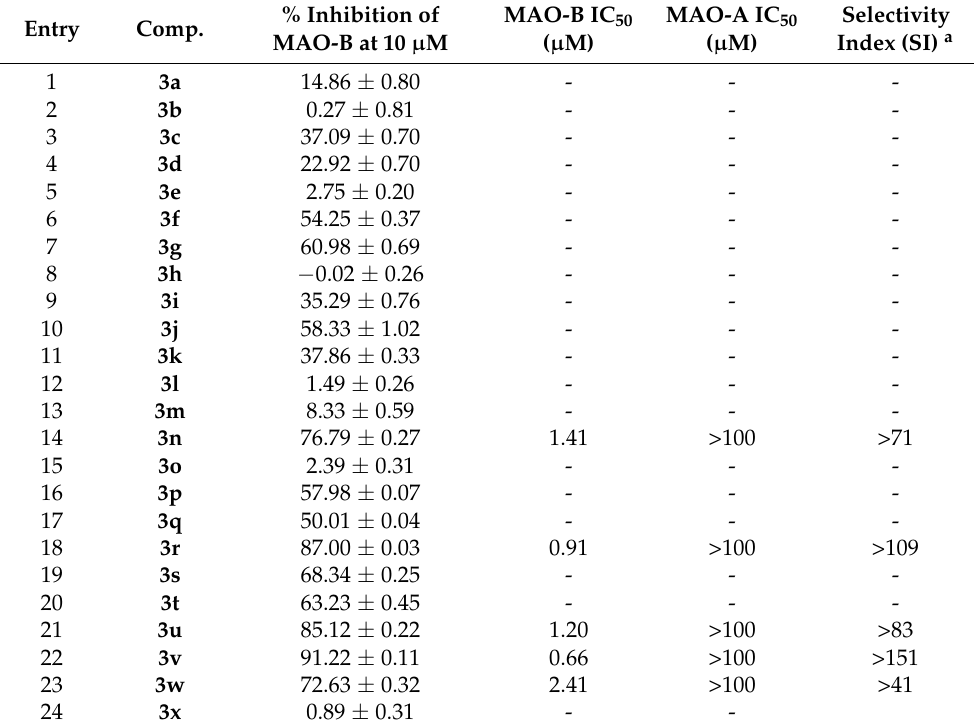
Table 3. Inhibitory effects of the melatonin analogues 3a – x against MAO enzymes.